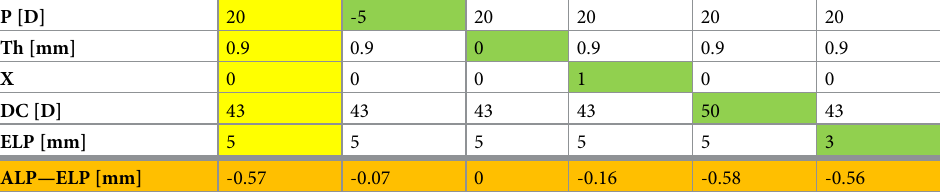
Table 1. Difference between the anterior intraocular lens vertex and the effective lens position of the thin lens equivalent for different model parameters. The initial settings are highlighted in yellow, the parameters that were varied are highlighted in